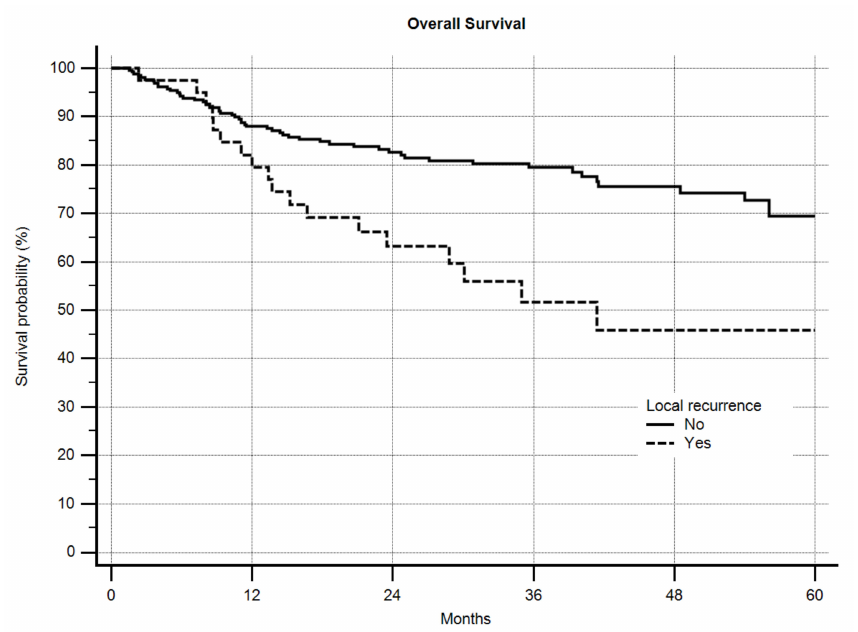
Figure 4. Overall survival by margin (R0, R1, R2), n = 305, p = 0.0005.